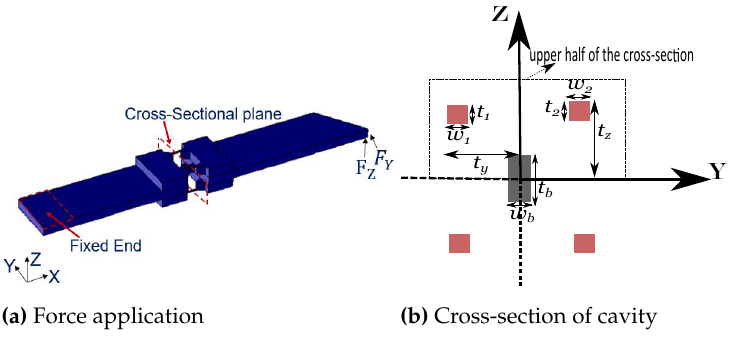
Figure 4. Force application in COMSOL, and the cross-section view of the cavity. In COMSOL Multiphysics, a surface load of 10 mN (across a 50 µ m × 50 µ m tip